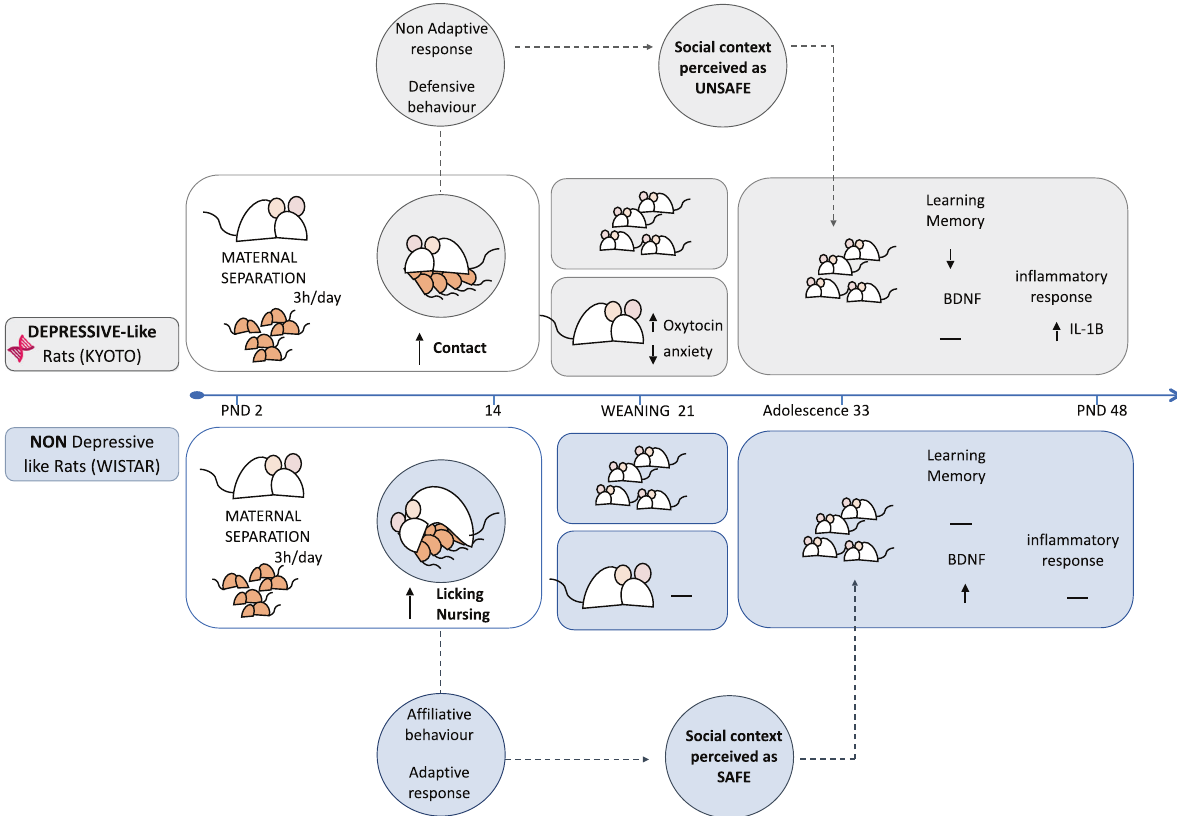
Fig. 6 Graphical summary of main fi ndings. Our results showed that mothers with different depression-like vulnerabilities facing maternal stress (induced by MS) adopted different strategies. Although both strains increased the maternal behavior in response to MS, non- depressive-like mothers (Wistar) exhibited a higher quality maternal behavior (af fi liative), showing a more adaptive response and more pro- social behavior (more active strategy). On the other hand, depressive-like mothers (Kyoto) displayed a more passive/defensive strategy (non- adaptive response) in response to MS. The higher levels of oxytocin observed in Kyoto mothers that experienced MS seem to be part of the stress-response mechanism, which ampli fi es the negative perception of the environment (as insecure), leading to a more defensive behavior by keeping the pups very close to them and away from outsiders (out-group anti-social behavior). This increase in oxytocin expression seems to decrease the anxiety-like state in Kyoto dams in response to MS. Furthermore, the quality of maternal behavior observed in non-depressive- like mothers (Wistar) after MS seems to protect the cognitive performance of adolescent rats from the negative effects of MS, leading to an increase of BDNF expression in the offspring hippocampus. On the other hand, depressive-like adolescents showed lower resilience to MS effects, exhibiting worst performance in the cognitive tests and alteration in the IL-1 β